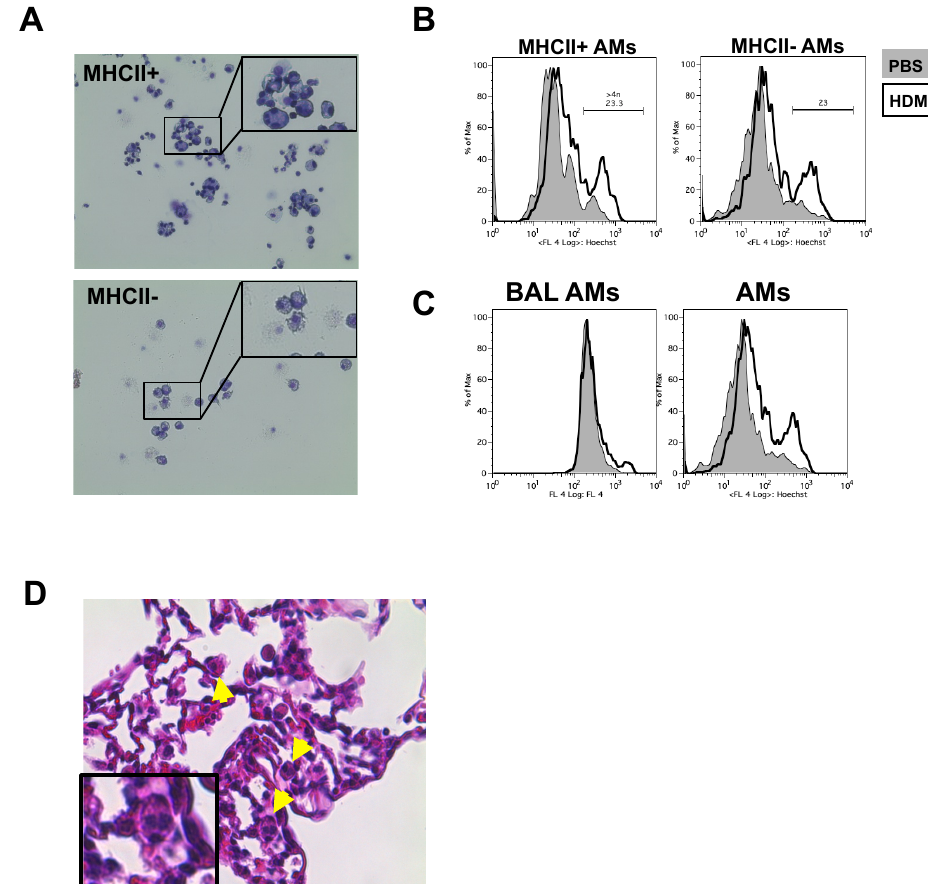
Figure 2. MHCII + tAMs subpopulation shows signs of polynucleation upon allergic asthma ( A ) CD11c + SiglecF + MHCII + resident tAMs from HDM-triggered asthmatic lungs but not the MCHII- subpopulation; showing cells with four to six nuclei. Data shown are representative of at least three independent experiments. Pictures were taken with a 20 × objective. ( B ) CD11c + SiglecF + tAMs from HDM-induced asthma show increased DNA content by Hoechst 33342 staining. Data are representative of at least two independent experiments. ( C ) DNA content increase is observed in tissue tAMs but not in bronchoalveolar macrophages as shown by Hoechst 33342 staining. Data are representative of at least two independent experiments. ( D ) Histology section of HDM-treated mouse. Arrows indicate the presence of polynucleated cells in the alveolar compartment. Pictures were taken using a 20 ×